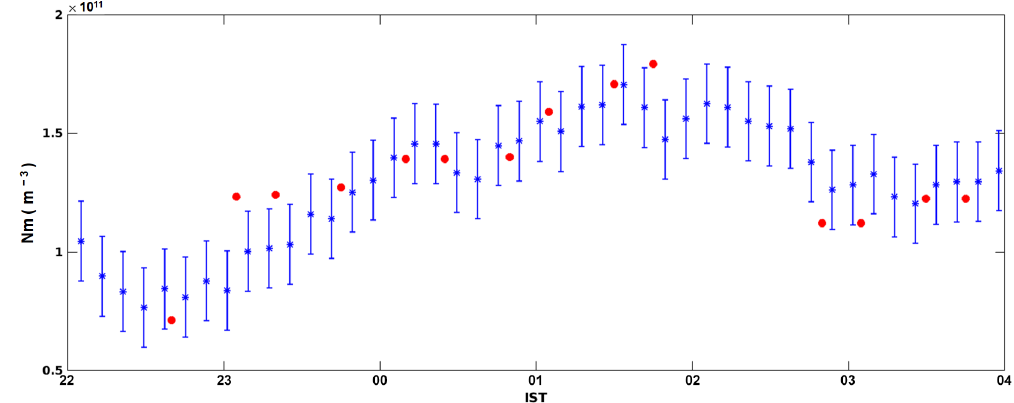
Figure 7. A limited comparison of airglow-derived Nm with ionosonde measurements on 9 January 2016 (22:00–04:00).